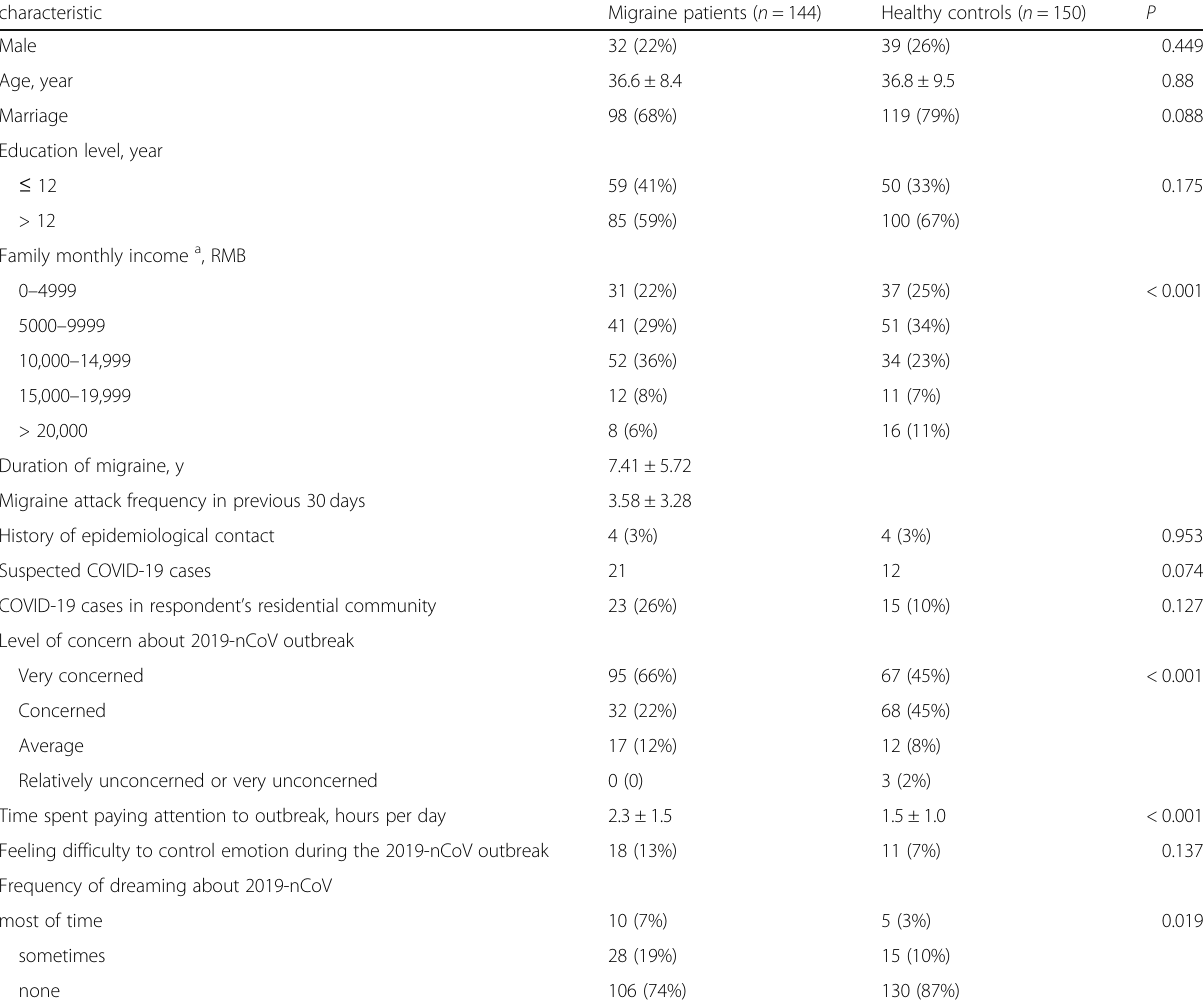
Table 1 Clinicodemographic characteristics of